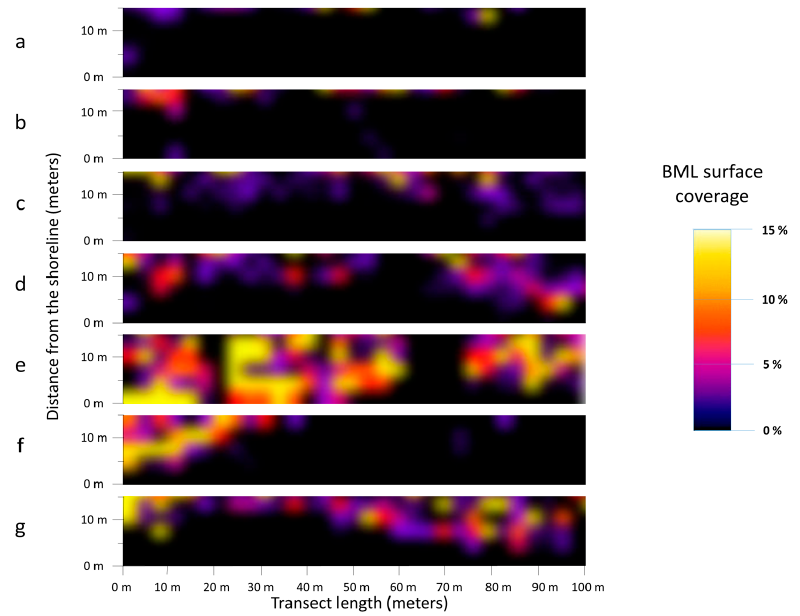
Figure 9. Variation in beached marine litter surface coverage of the monitored area, over time, for the second temporal period (from half July 2019 to January 2020). The correspondent dates were: ( a ) 19 July 2019; ( b ) 21 August 2019; ( c ) 18 September 2019, ( d ) 03 October 2019, ( e ) 20 November 2019, ( f ) 11 December 2019; and ( g ) 17 January 2020. As in Figure 8, the pattern of spatial and temporal distribution highlights the accumulation of waste increasing in the upper part of the strips (dune zones). In strip ( e ) the “footprint” of the Arno flooding, that occurred during the correspondent time period, is